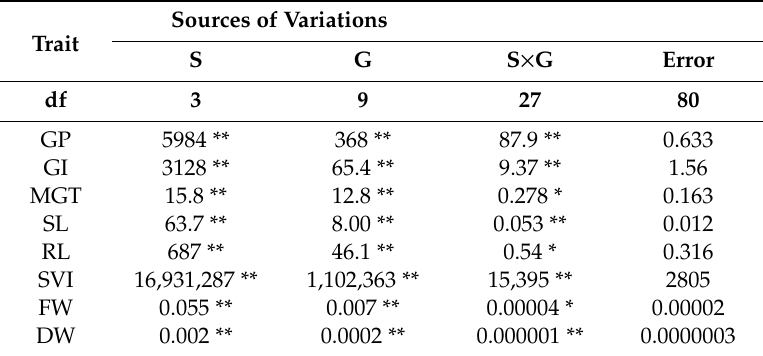
Table 1. Analysis of variance (mean squares) for different parameters of ten sorghum genotypes in four salinity treatments.